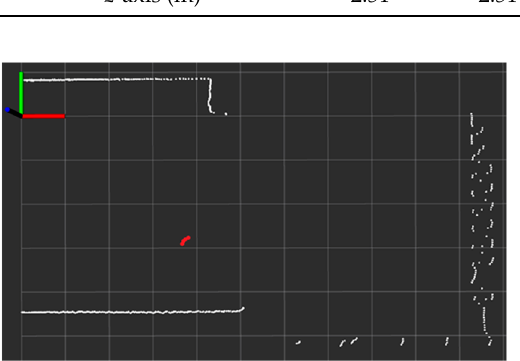
Figure 10. ROS visualization of real-time Hokuyo Lidar’s scan in Hokuyo reference frame of same scene portrayed in Figure 9a (white dots = redundant surrounding boundaries; red dots = pedestrian’s head position; per unit box = 1 m × 1 m).